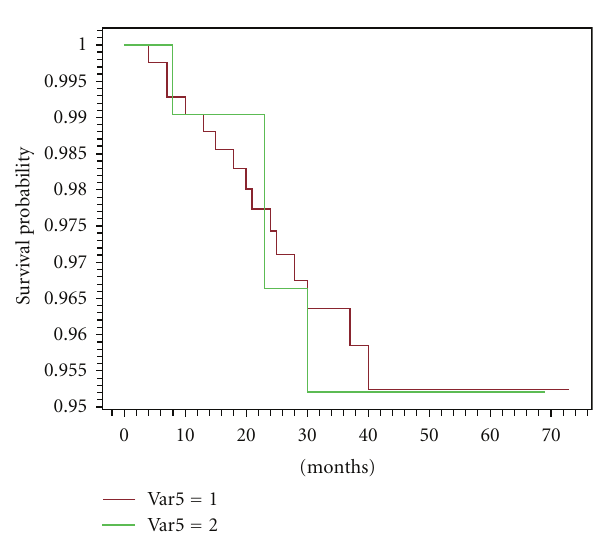
∗ Patients with synchronous contra lateral surgery were excluded.